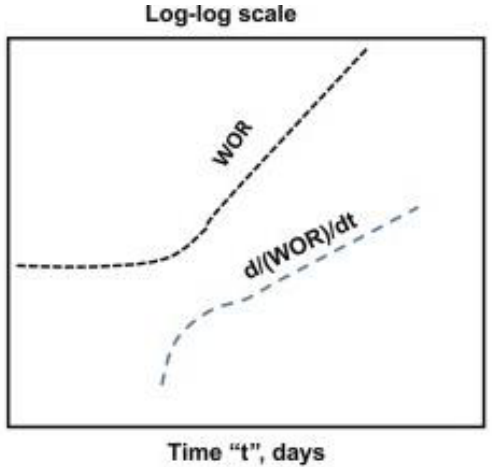
Figure 2. Channeling WOR and WOR’ derivates [ 5].